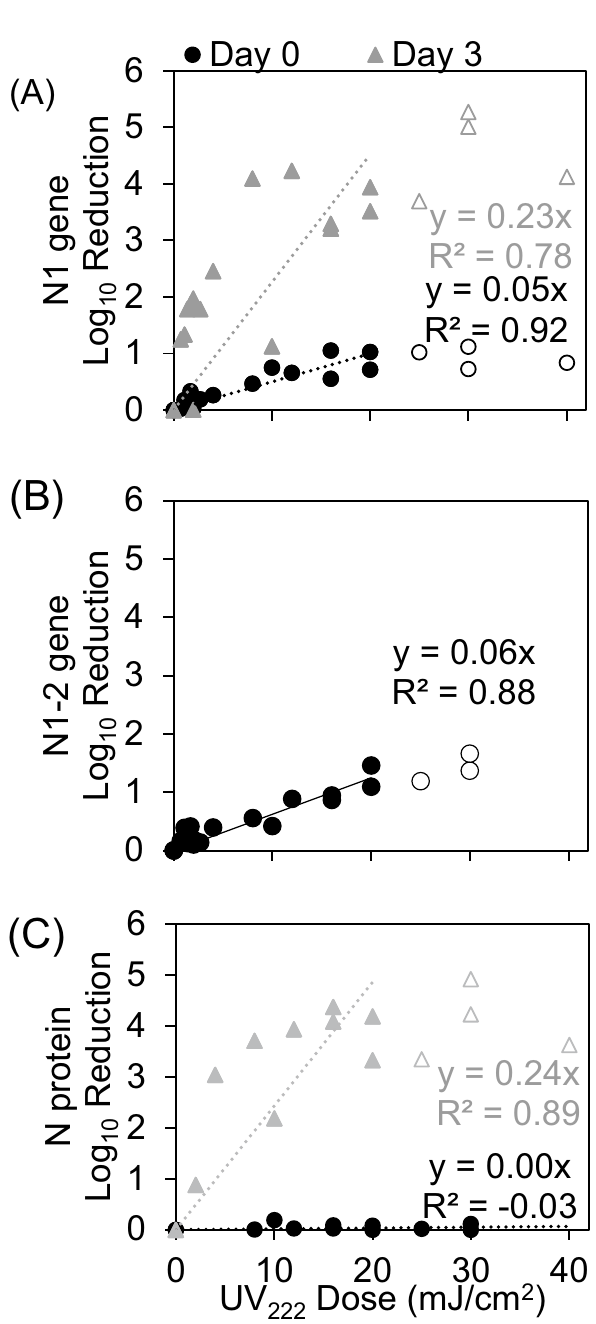
Figure 3. ( A ) SARS-CoV-2 N gene damage immediately after UV treatment (Day 0) and after incubation of samples with host cells (Day 3) expressed as log 10 reduction of N1 (short amplicon) copies/µL in qPCR reactions. ( B ) SARS-CoV-2 N gene damage immediately after UV treatment (Day 0) expressed as log 10 reduction of N1-2 (long amplicon) copies/µL in qPCR reactions. ( C ) SARS-CoV-2 N protein concentration measured by ELISA expressed as log 10 reduction of N protein concentration (pg/mL) in samples immediately after UV treatment (Day 0) and after incubation of samples with host cells (Day 3). SARS-CoV-2 log 10 reductions of the N1 amplicon, N1-2 amplicon, or N protein versus UV 222 dose were fit with a linear model forced through the origin at 0 mJ/cm 2 through responses up to and including 20 mJ/cm 2 indicated by filled circles. Points not included in models are indicated by hollow